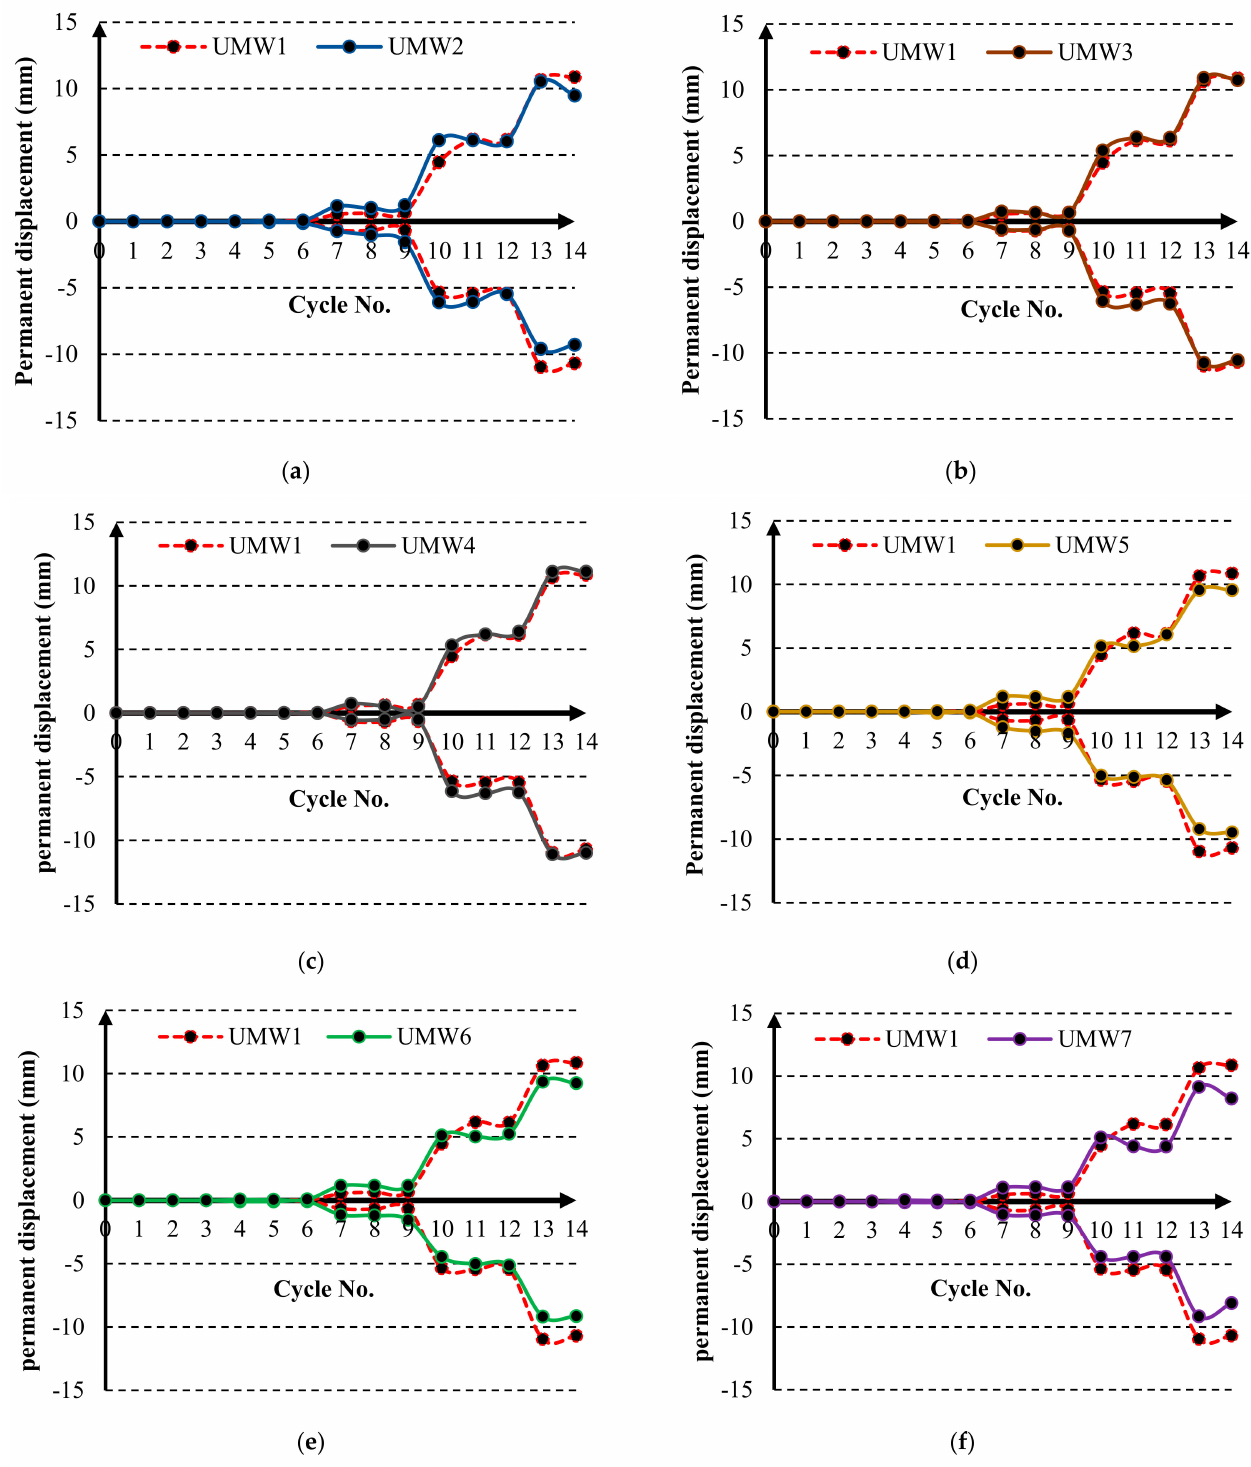
Figure 20. Permanent deformation during the cyclic loading for models, ( a ) UMW2, ( b ) UMW3, ( c ) UMW4, ( d ) UMW5, ( e ) UMW6, and ( f )